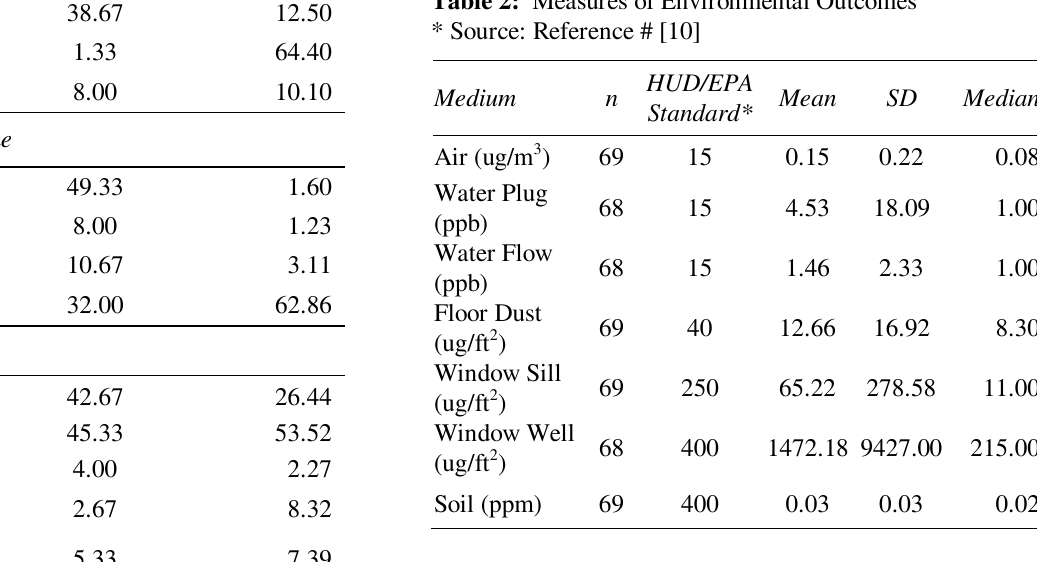
Table 2: Measures of Environmental